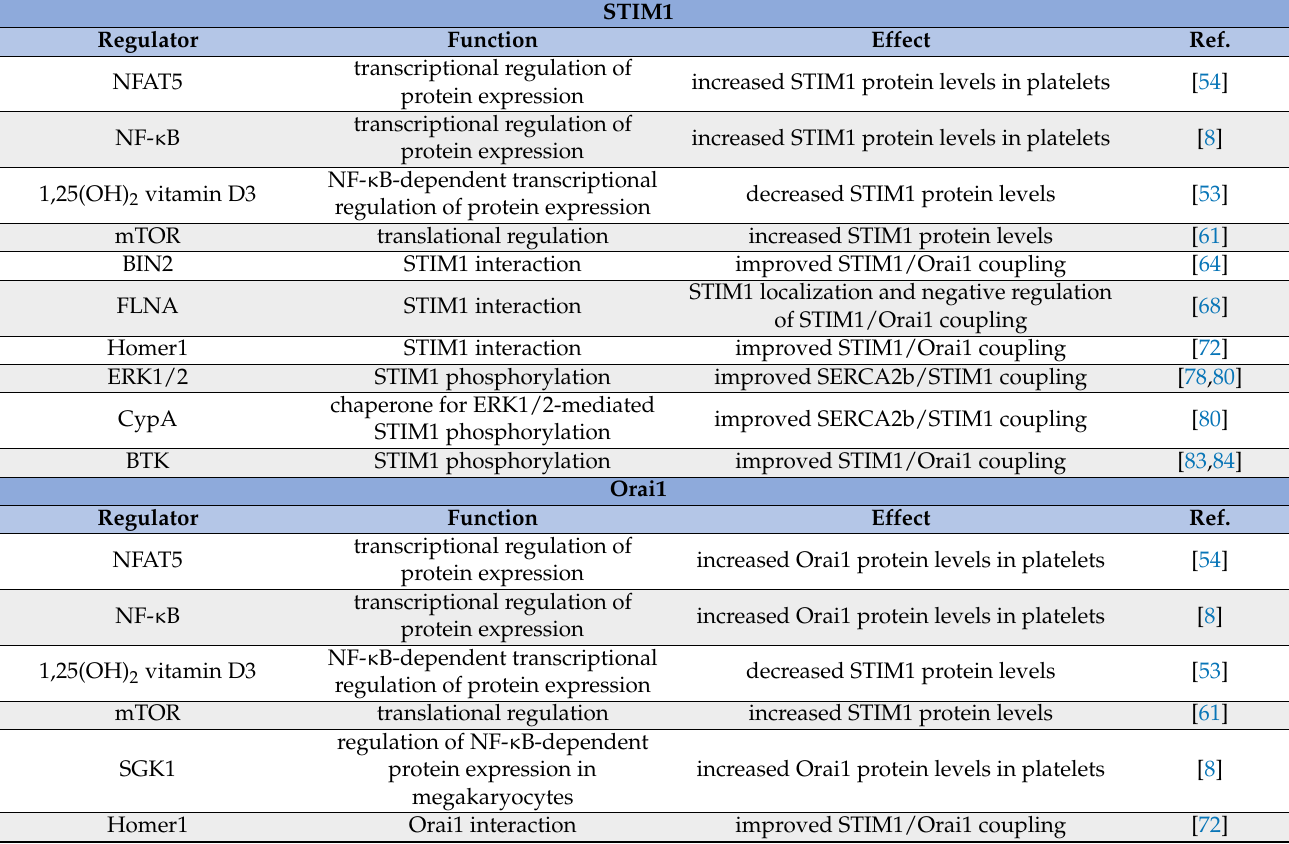
Table 1. Described direct regulators of STIM1/Orai1-mediated SOCE in platelets. STIM1